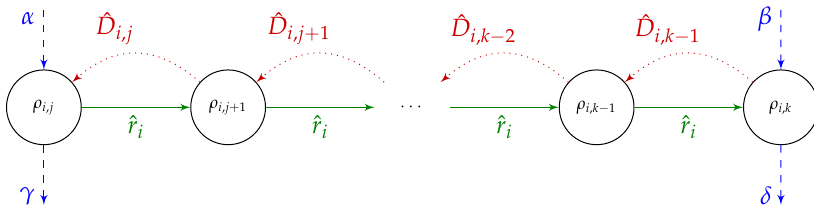
Figure 5. A general structure of L- and